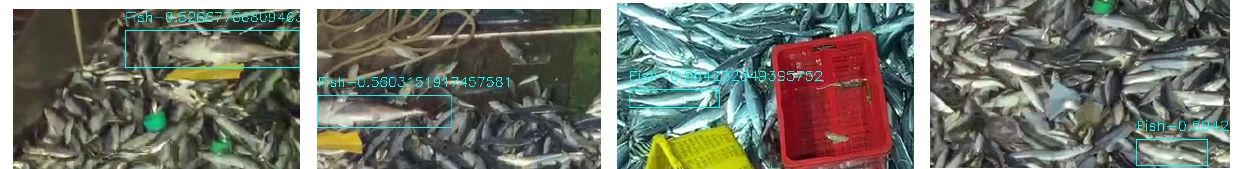
Figure 6. Prediction results for the first quadrant image.